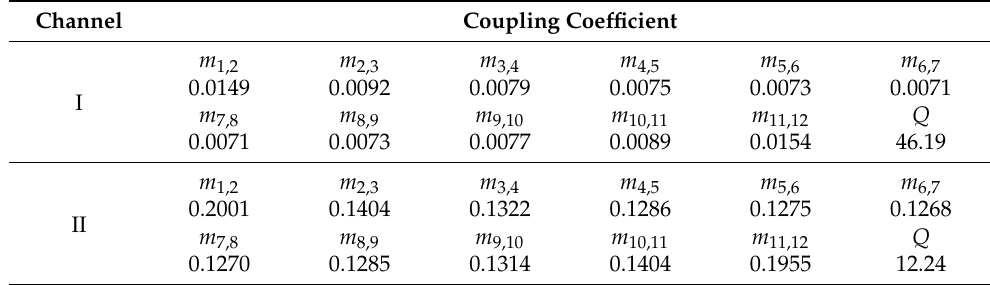
Table 3. The coupling coefficient of the diplexer.